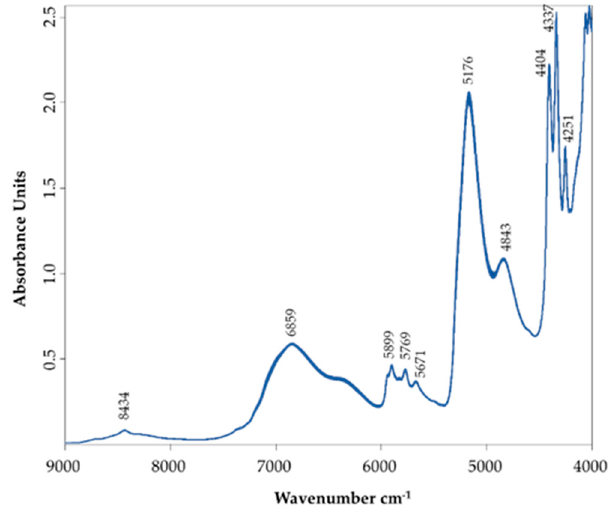
Figure 4. Representative absorption spectra of all AWS samples acquired in the NIR region measured against a background of air.